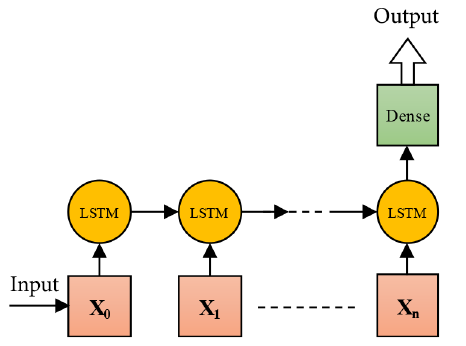
Figure 1. LSTM architecture (Atienza, Posted on 2017)